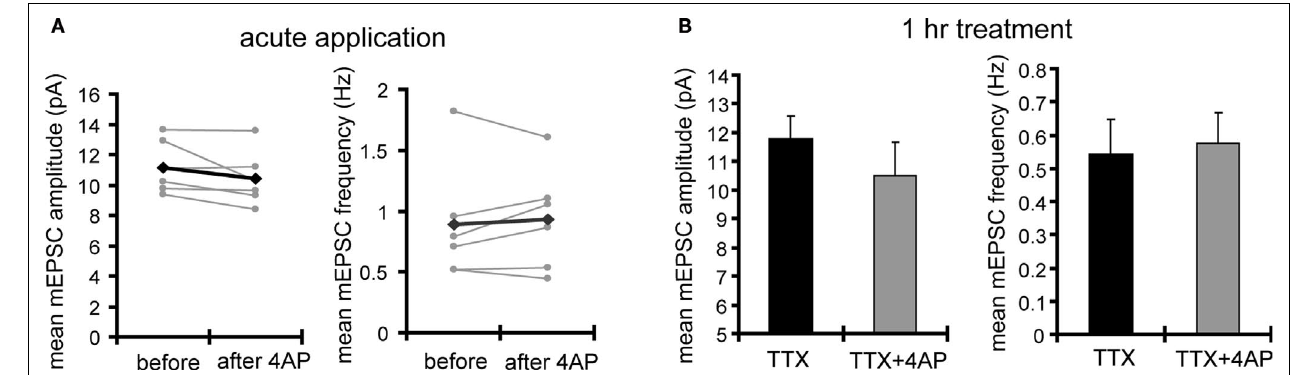
FIGURE 2 | Acute application of 4AP infl uences neither the amplitude nor the frequency of mEPSCs. (A) 4AP (5 mM) was applied during mEPSC recording from the soma. Data from individual experiments are represented by gray circles and black diamonds represent the mean ( n = 6). The results indicate that 4AP does not have an immediate infl uence on mEPSC amplitude or frequency under our recording conditions. Note that most postsynaptic A-type